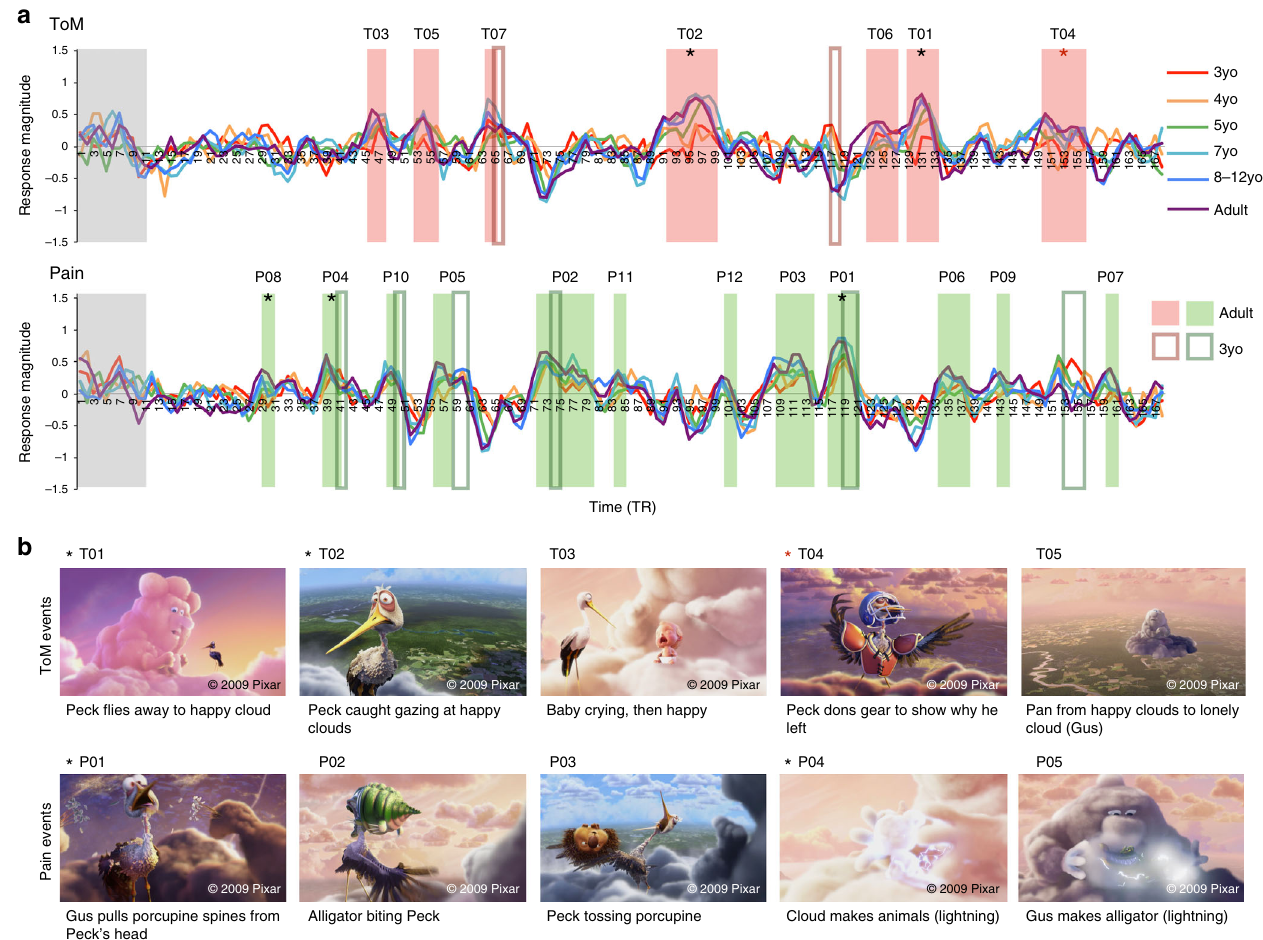
Fig. 4 Reverse Correlation Analysis. a The average timecourse per age group for the ToM network (top) and Pain matrix (bottom), during viewing of ‘ Partly Cloudy ’ 61 . Each timepoint along the x -axis corresponds to a single TR (2 s); the entire movie was 168 TRs (<6 min). Shaded blocks show timepoints identi fi ed as ToM (red) and Pain (green) events in a reverse correlation analysis conducted on adults ( n = 33); timepoints within the gray block correspond to the opening logos of the movie and were not analyzed. Dark red and green borders show timepoints identi fi ed as ToM and pain events, respectively, in 3-year-old children ( n = 17). Event labels (e.g., T01, P01) indicate ranking of average magnitude of response in adults. Asterisks indicate signi fi cant positive correlations between peak magnitude of response and age (continuous variable; black) and ToM behavioral score (continuous variable; red), after correcting for multiple comparisons (age: 19 ToM/Pain events, α = .0026; ToM: 7 ToM events, α = .007). b Example frames and descriptions for the fi ve events with the highest magnitude of response in adults, per network (see Supplementary Fig. 5 for all events, Supplementary Table 3 for fuller event descriptions and timing and duration information, and Supplementary Fig. 6 for a replication in an independent sample of adults). Images ©2009 Pixar, reused with permission. These images are not covered under the CC BY license for this correlation, within-network correlation, age, and motion on functional maturity measure ( n = 122): ToM: effect of across-